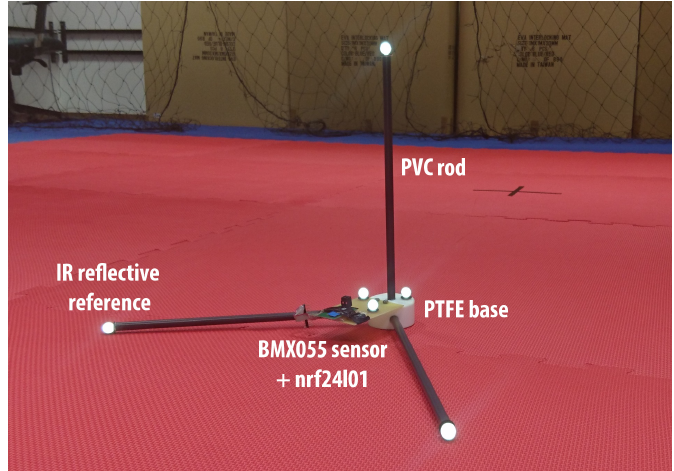
Figure 3. The measuring platform in the VICON